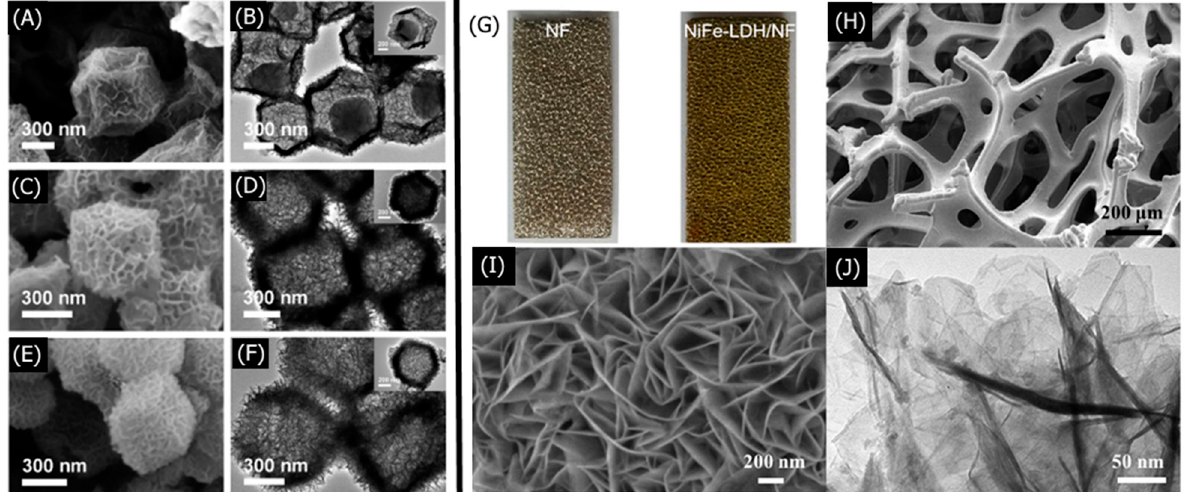
Figure 5. SEM and TEM micrographs of ( A , B ) Co 0.52 Ni 0.48 -LDH; ( C , D ) Co 0.33 Ni 0.67 ; and ( E , F ) Co 0.21 Ni 0.79 reproduced from reference [117] with per mission from American Chemical Society, 2019 ( G ) Digital photograph of Ni foam and NiFe-LDH modified Ni foam. ( H ) Low and ( I ) high magnification SEM micrographs of NiFe-LDH on Ni Foam. ( J ) TEM of the NiFe-LDH nanosheets reproduced from reference [46] with permission from Wiley, 2017.